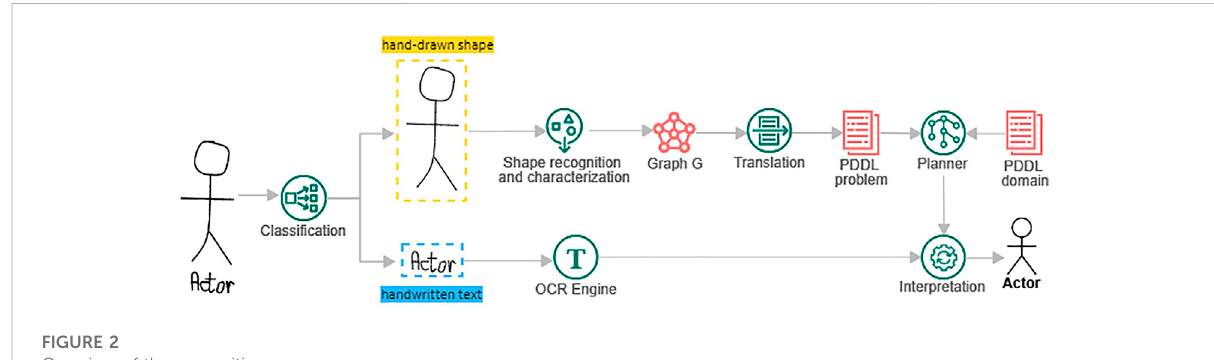
FIGURE 2 Overview of the recognition